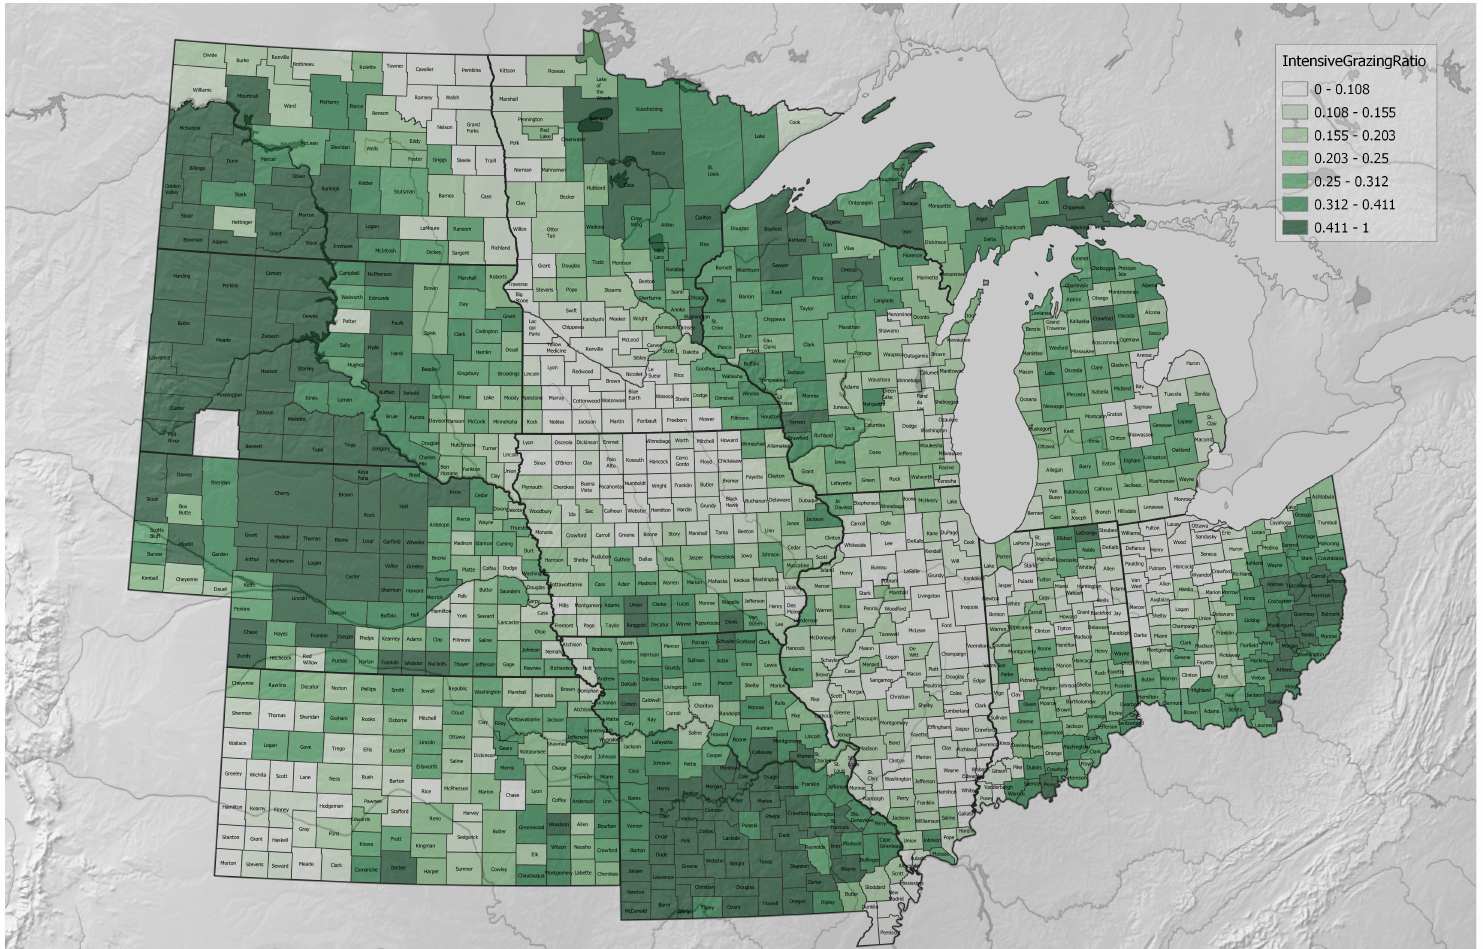
Figure A1. Fraction of farms practicing intensive grazing, 2017. Values were all rescaled through dividing by the largest value present for any of the counties included here (0.422 in Thomas County, Nebraska), as this transformation was applied to the variable data as they were placed into the index expression. Methods for IntensiveGrazingRatio are described in the article main text and Supplementary Materials. USDA 2017 Census of Agriculture data [52] were